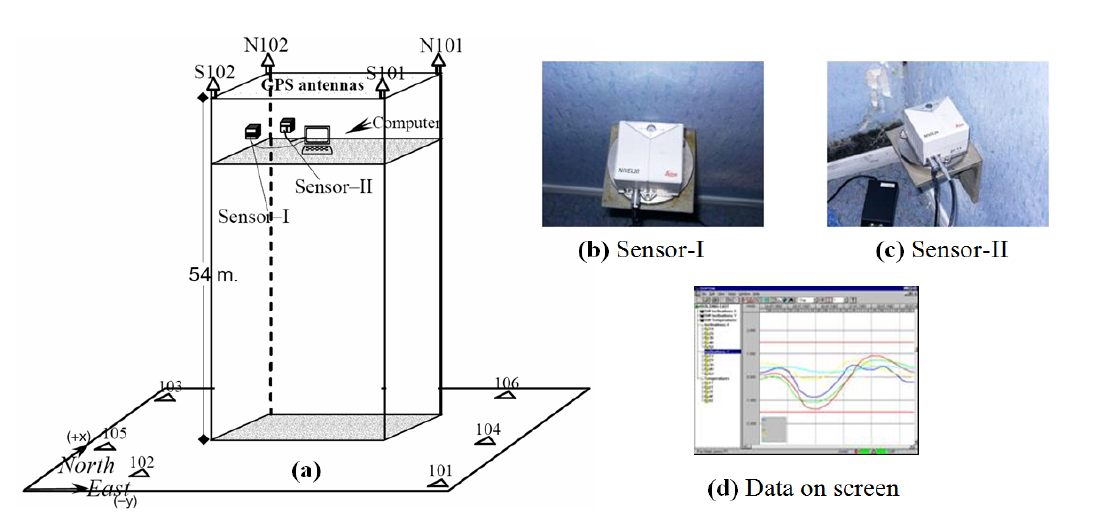
Figure 4. (a) Monitoring setup of the tall building: locations of inclination sensors and the deformation network benchmarks on and around the building [30], (b,c) instruments used in the study, (d) user interface of the monitoring